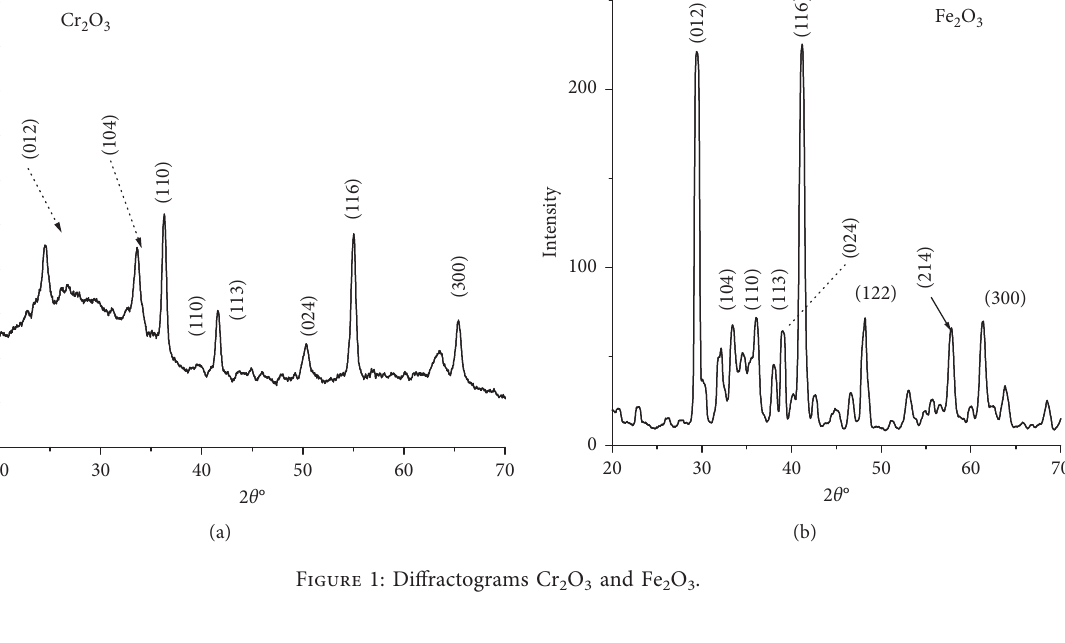
2 O 3 and Fe 2 O 3 .